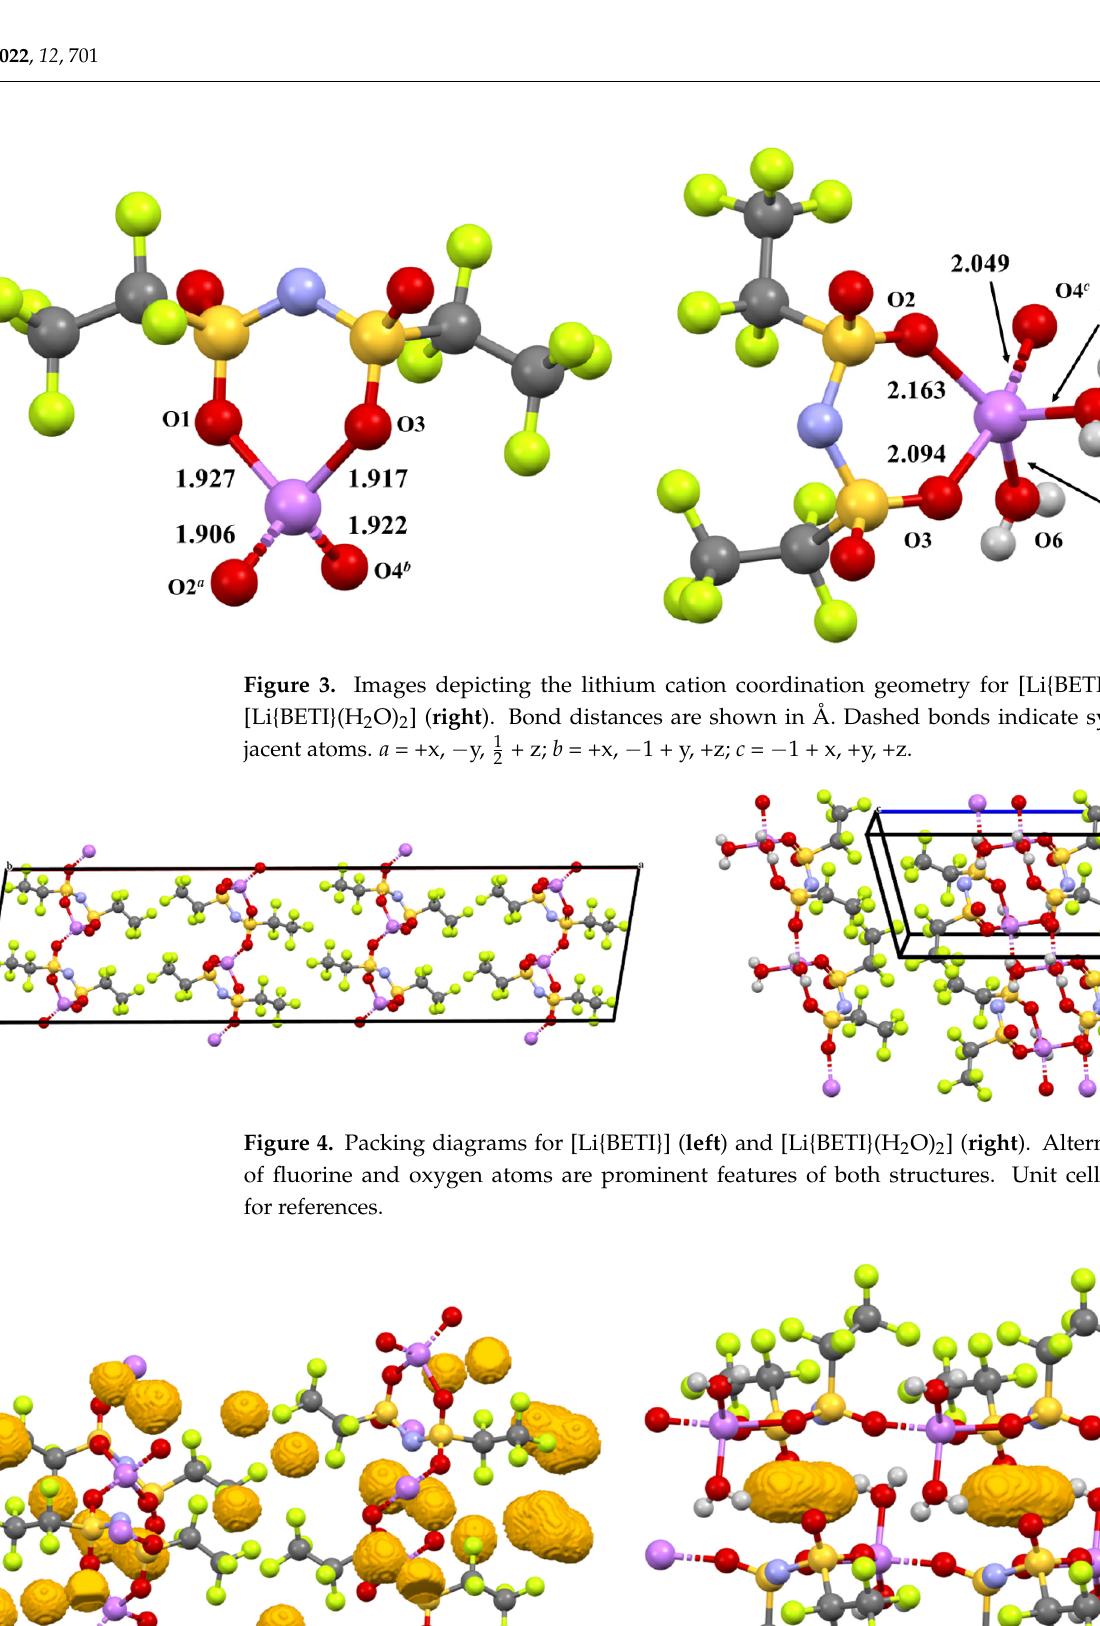
5 of 13 Figure 2. Asymmetric units of [Li{BETI}] ( left ) and [Li{BETI}(H 2 O) 2 ] ( right ) shown with 50% proba- bility ellipsoids. Gray, carbon; green, fluorine; red, oxygen; pink, lithium; yellow, sulfur; blue, ni- trogen. Several potential factors influence the distances and interactions in the two mole- cules. Predominantly, the coordination geometry of the lithium is a factor. In [Li{BETI}], the lithium exists in a pseudo-tetrahedral geometry with four oxygen atoms making bonds to the metal. Two of the oxygens are from a single bidentate [BETI] − anion, and the remaining oxygens are from symmetry adjacent anions, effectively making an infinite chain linked through the lithium ion (see Figure 3). In [Li{BETI}(H 2 O) 2 ], the lithium atom exists in a distorted trigonal bipyramidal geometry with two water molecules, one biden-